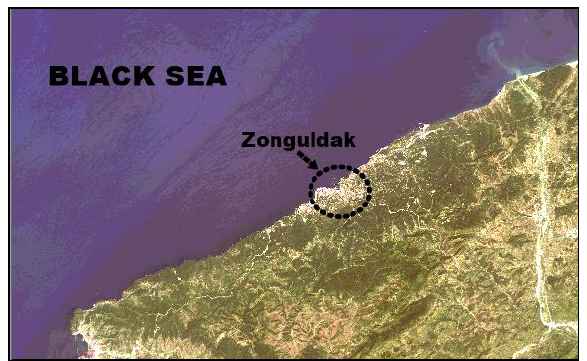
Figure 1. Study Area Zonguldak, Turkey (Landsat-8